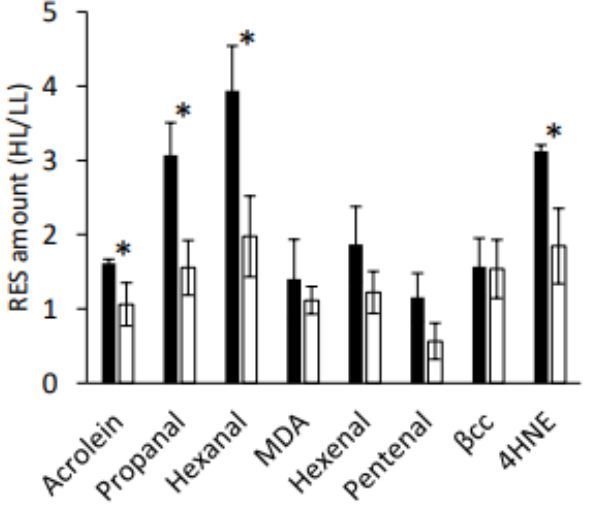
Figure 3. Influence of GPX5 overexpression on aldehyde/RES accumulation. Change in RES concen- trations in response to HL (600 µ mol photons m − 2 s − 1 ) for 4 h, relative to levels before treatment at LL (50 µ mol photons m − 2 s − 1 ), in wild-type (black) and GPXHOX-11 (white). MDA: malondialdehyde, β cc: β -cyclocitral, 4HNE: 4-hydroxynonenal. n = 4 ± SD with * denoting significant differences between genotypes ( p < 0.05).